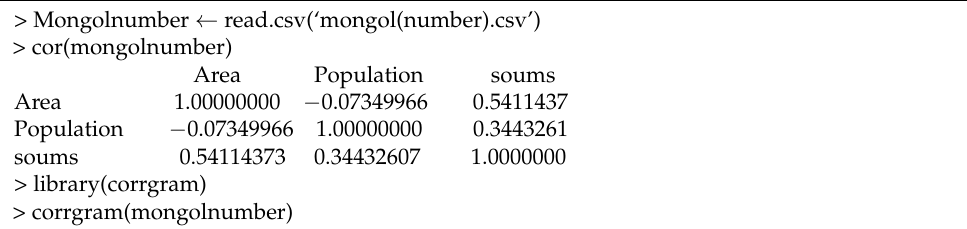
Figure 9. Information about each province in Mongolia big data visualization. Table 5. Information about each province in Mongolia big data visualization script.